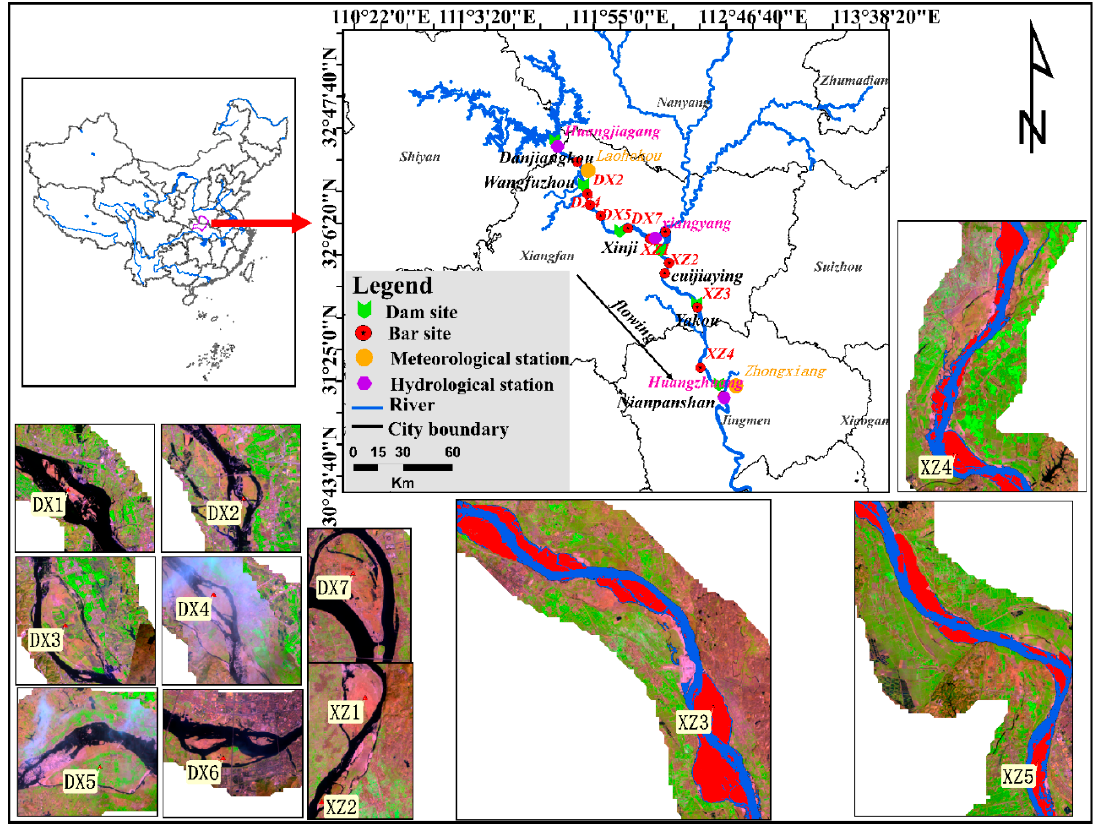
Figure 1. Location of the cascade reservoirs and channel bars in the middle reaches of the Hanjiang River (channel bars are highlighted with Landsat-8 (Operational Land Imager, OLI) imagery from 2018 (bands combination of Short-wave infrared (SWIR1), Near-infrared (NIR), and Red), and Xiangyang-Huangzhuang 3 (XZ3), XZ4, and XZ5 are shoal groups displayed in the red area). Table 1. Information of the cascade reservoirs in the middle reaches of Hanjiang River.